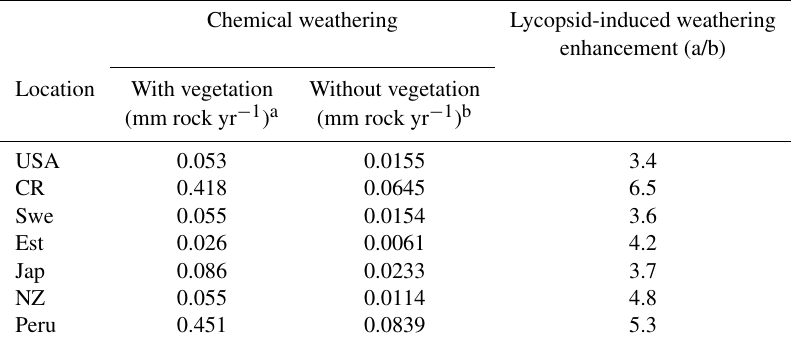
Table 5. Comparison of supply limited eco-hydrological-controlled weathering regimes with vegetation (a) and without vegetation (b). In addition, the percolation rate is doubled in the with vegetation (a) scenario, which incorporates the impact of roots on the soil (making it more